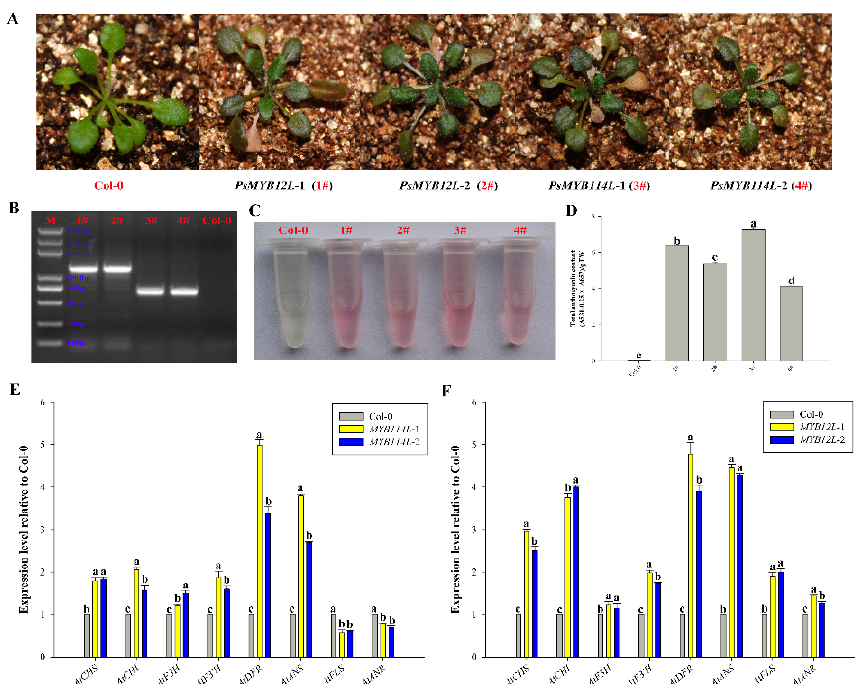
Figure 6. Overexpression analysis of the PsMYB114L and PsMYB12L genes in Arabidopsis . ( A ) Comparison of leaf colors in transgenic Arabidopsis plants and Col-0. ( B ) Results of positive PCR detection in transgenic Arabidopsis plants. ( C ) Anthocyanin extraction solutions for transgenic Arabidopsis plants and Col-0. ( D ) Total anthocyanin content in transgenic Arabidopsis plants and Col-0. ( E ) Expression analysis of anthocyanin biosynthesis-related genes in transgenic Arabidopsis plants of PsMYB114L and Col-0. ( F ) Expression analysis of anthocyanin biosynthesis-related genes in transgenic Arabidopsis plants of PsMYB12L and Col-0. Col-0, Arabidopsis thaliana ecotype Columbia; 1# and 2#, two transgenic lines of the PsMYB12L gene; 3# and 4#, two transgenic lines of the PsMYB114L gene. Different lowercase letters indicate significant differences at p < 0.05.